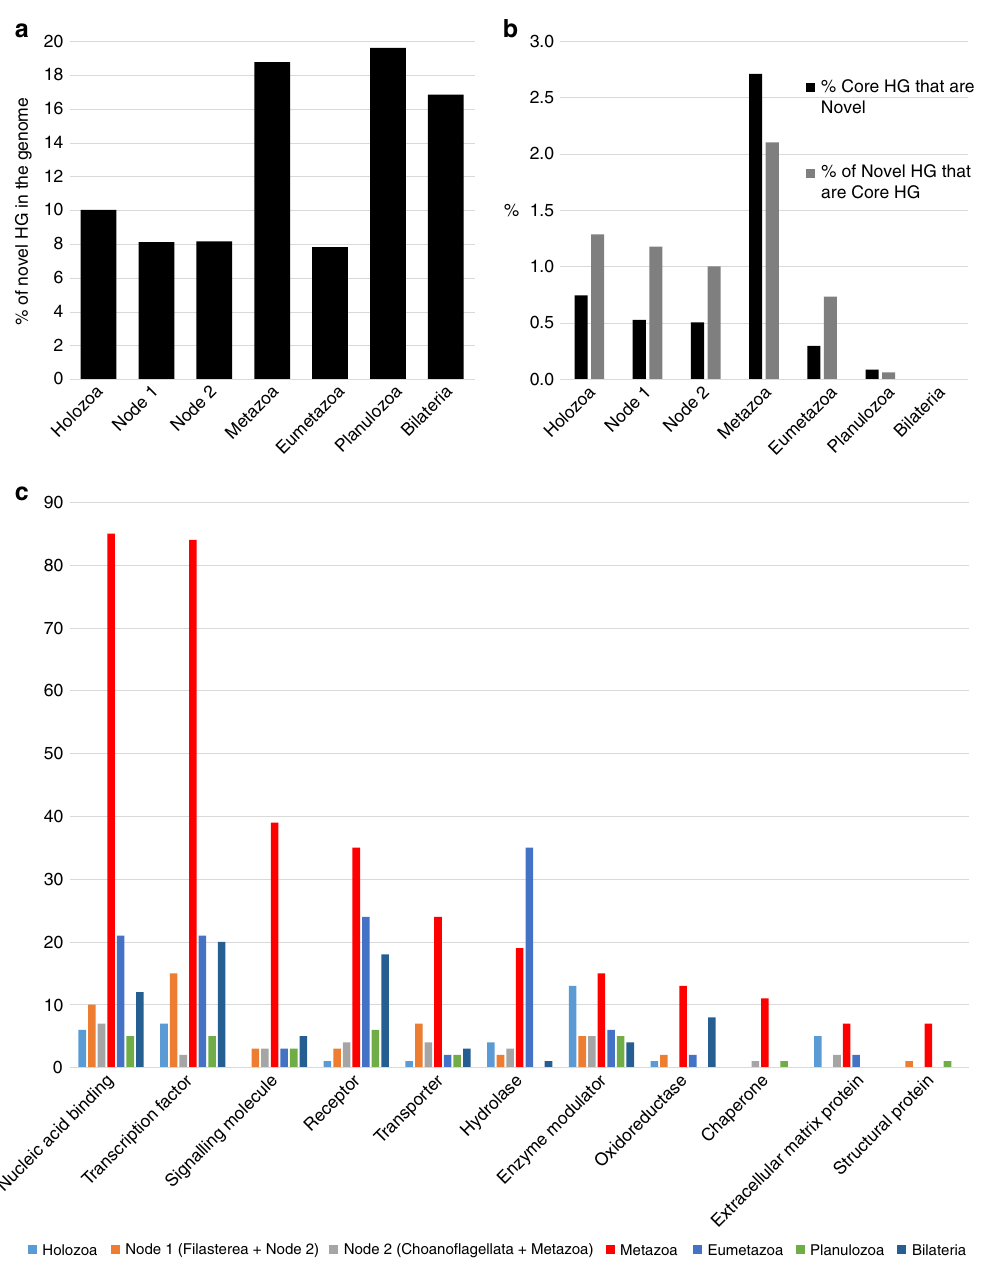
Fig. 2 Novelty in ancestral genomes. a Proportion of Novel HG in the Ancestral HG for different holozoan ancestors. b Percentage of Core HG that are novel, and percentage of highly preserved genes among the Novel HG across different LCA. c Number of Protein Class GO hits for the fruit fl y representatives of the Novel HG for the various phylogenetic